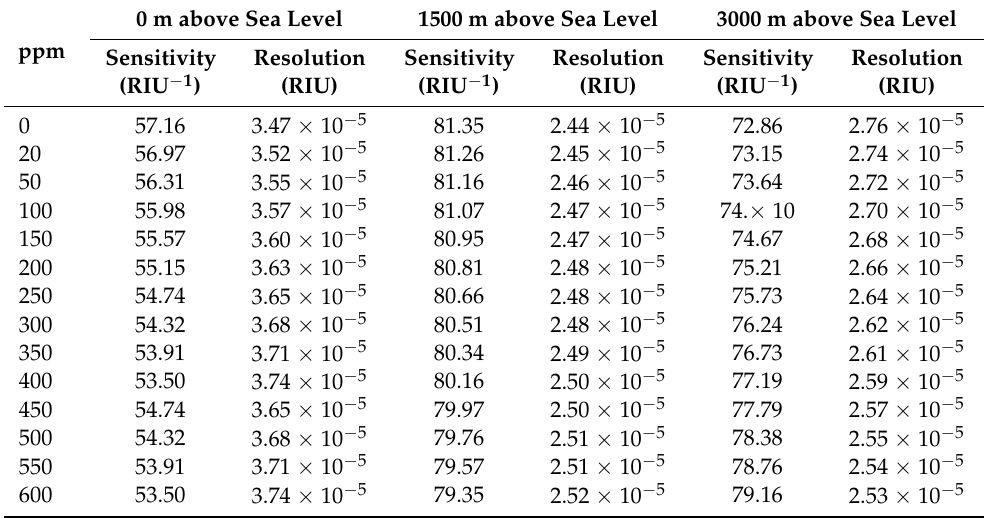
Table 1. Sensitivity and resolution for each height above sea level and each CO concentration.